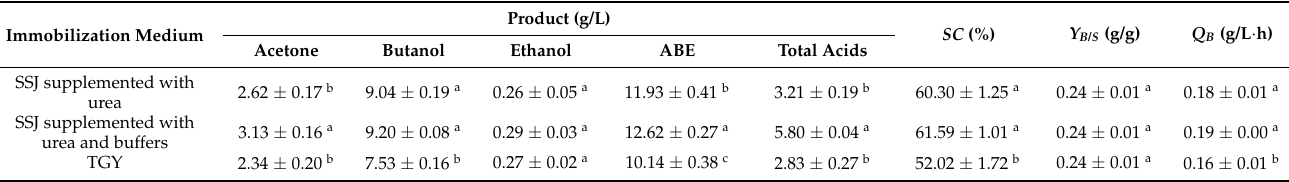
using different immobilization media at 48 h of